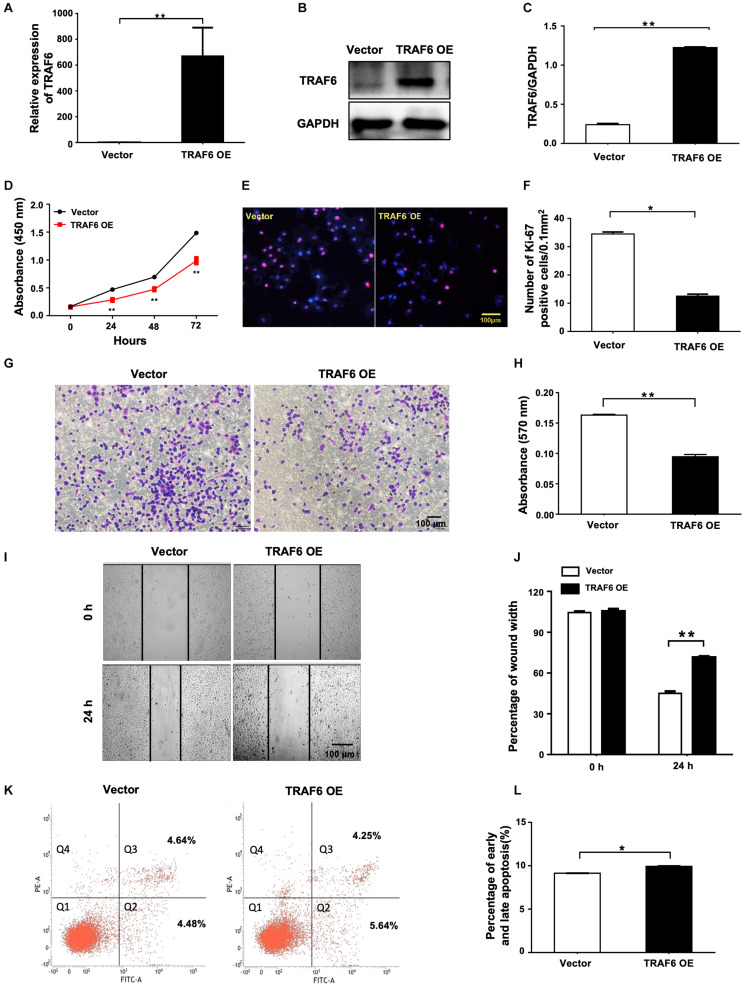
Overexpression of TRAF6 inhibits cell proliferation and migration but promotes apoptosis of NSCLC cells. (A) The expression of TRAF6 examined by qPCR. (B) The protein level of TRAF6. (C) Quantitation of the WB data as in (B). (D) Cell proliferation examined by CCK-8 assay. (E) Cell proliferation measured by Ki-67 staining. (F) Quantification of the Ki-67 staining assay result as in (E). (G) Migration ability detected by transwell assay. (H) Quantification of the transwell assay result as in (G). (I) Migration ability measured by wound-healing assay. (J) Quantification of the wound-healing assay result as in (I). (K) Early (Q2) and late apoptosis (Q3) measured by flow cytometry analysis. (L) Quantification of the FACS data as in (K). All experiments were performed in H1299 cells transfected with TRAF6 overexpression construct for 24 h except in (K) for 48 h. TRAF6 OE: overexpression vector of TRAF6.